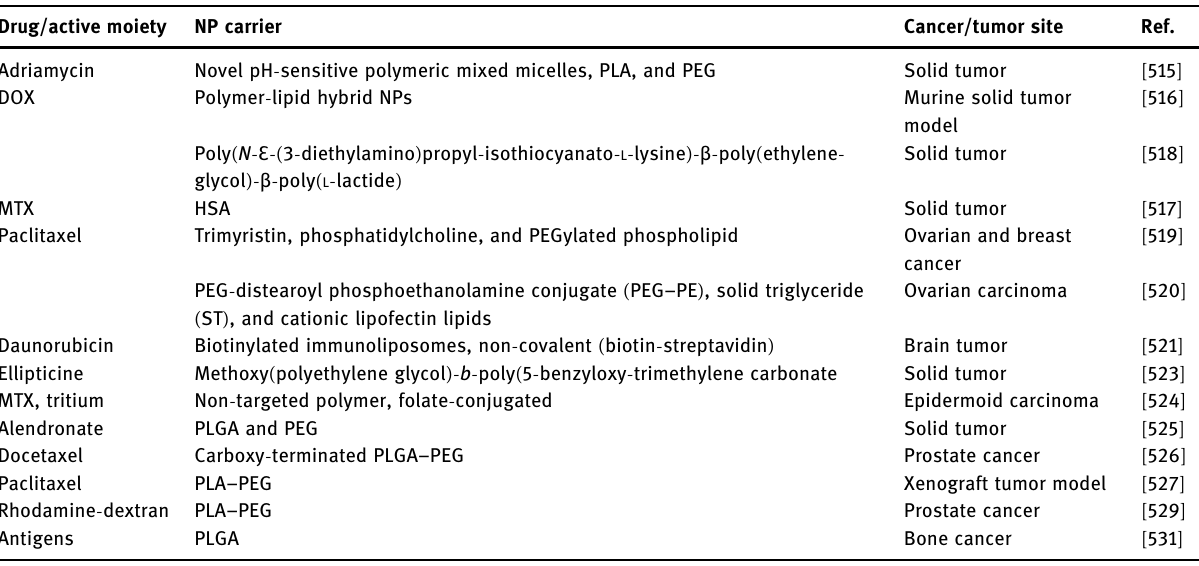
Table 6: Smart drug delivery nano - carriers used for the treatment of cancers Drug/active